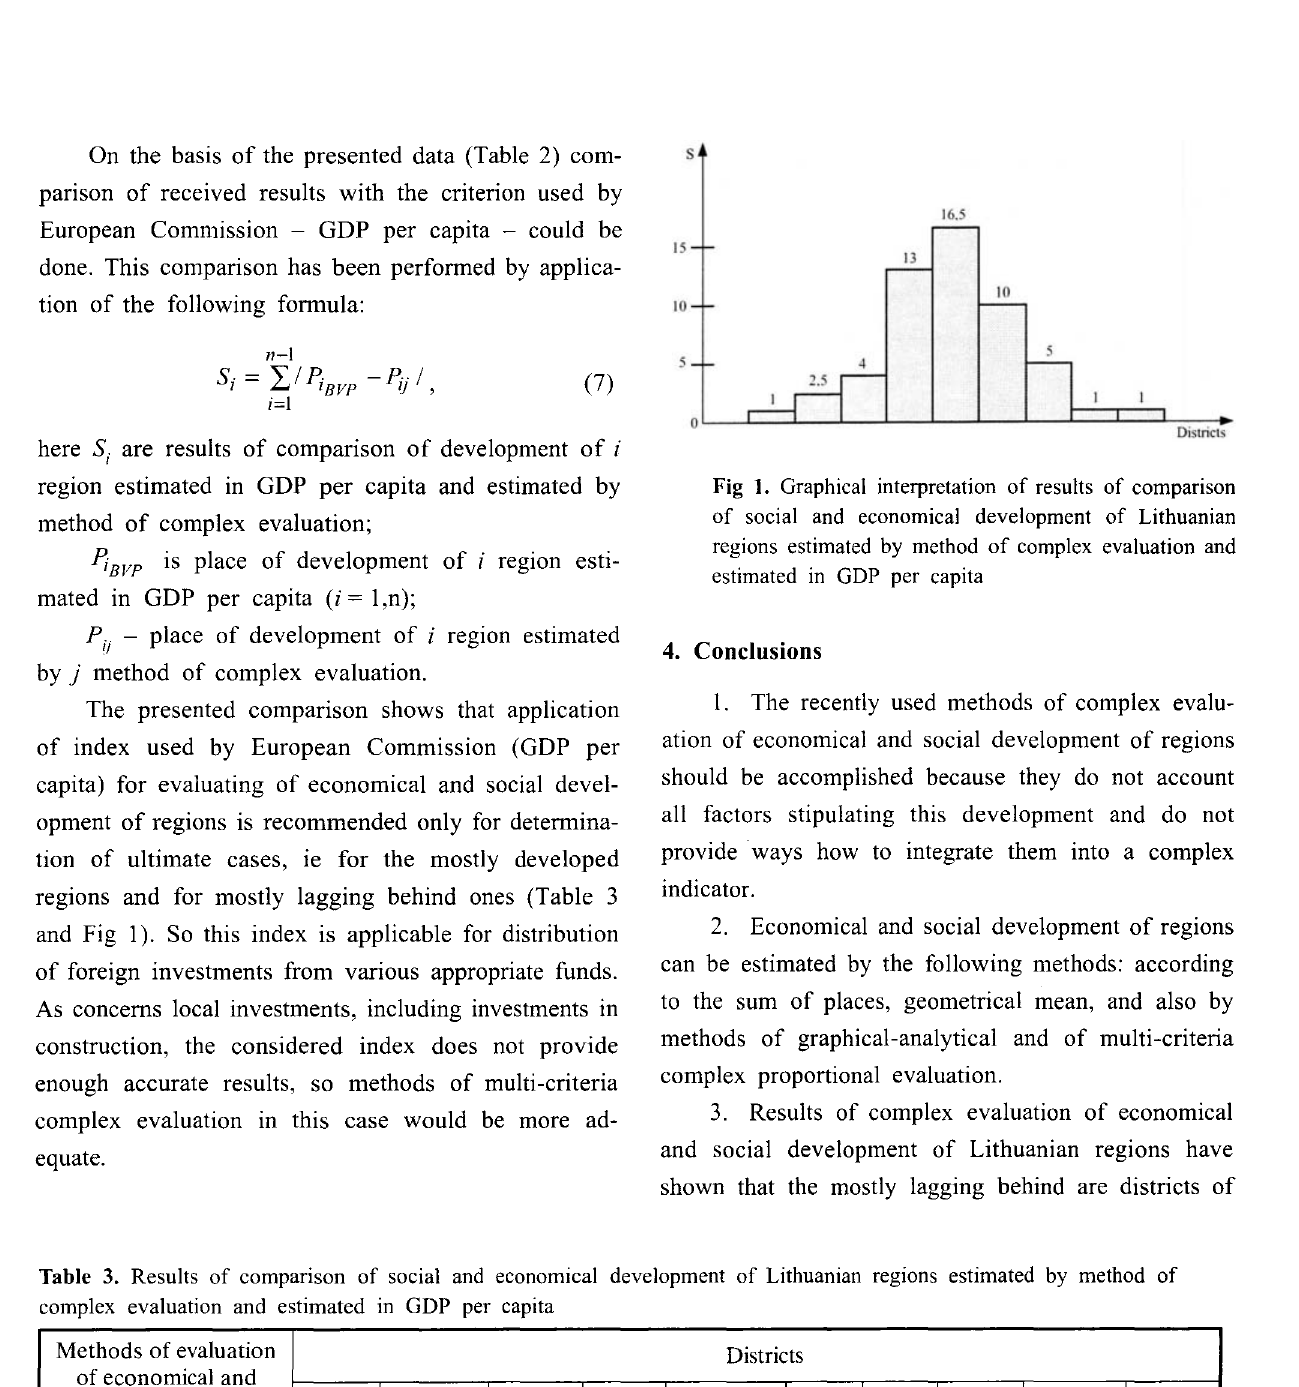
Table 3. Results of comparison of social and economical development of Lithuanian regions estimated by method of complex evaluation and estimated in GDP per capita Methods of evaluation Districts of economical and social development